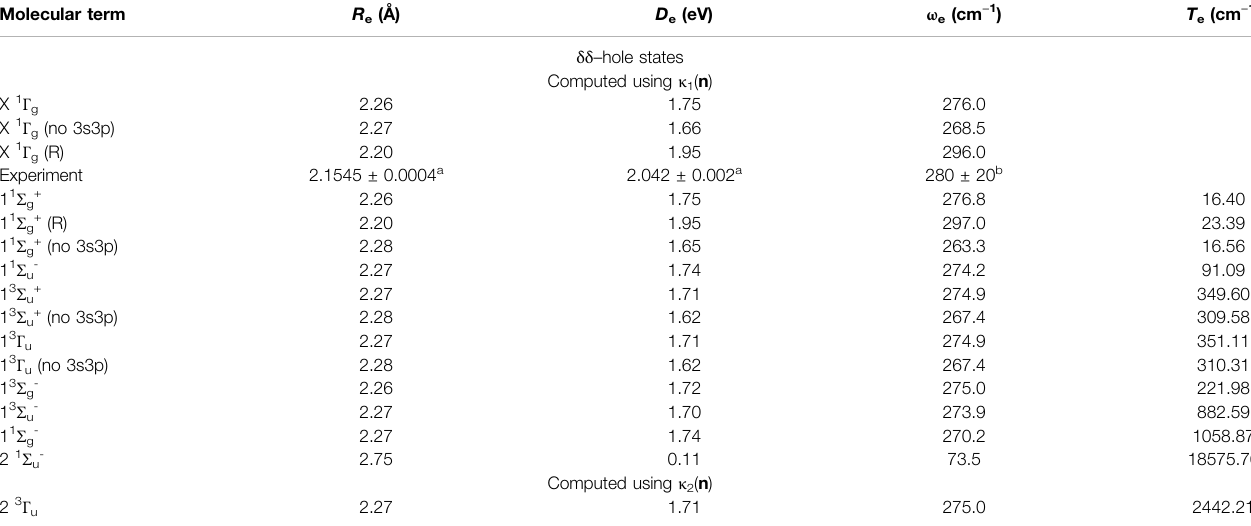
TABLE1| Equilibriumbondlengths, R e (Å),bindingenergies, D e (eV),harmonicfrequencies, ω e (cm − 1 ),andadiabatictransitionenergies, T e (cm − 1 ),ofelectronicstatesofNi 2 calculated at the GVVPT2 level of theory using the cc-pVTZ basis set (or cc-pVTZ-DK for scalar relativistic calculations). Molecular